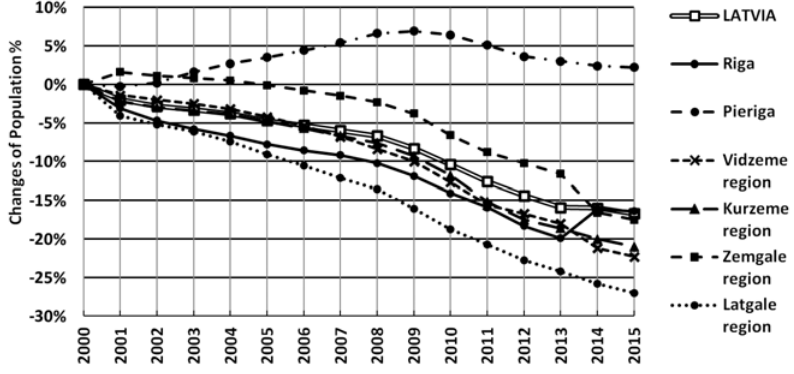
Fig. 2. Changes in the Number of Population in Latvian Regions, 2000-2015 Source: Central Statistical Bureau of Latvia.